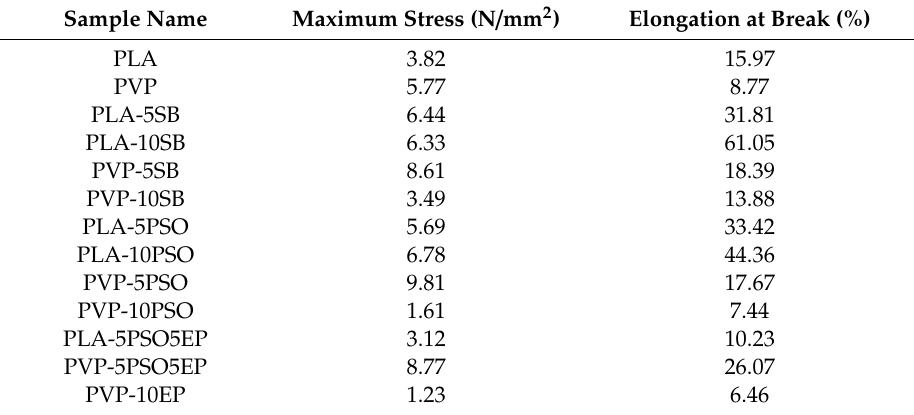
Table 3. Mechanical Properties of Prepared Samples.